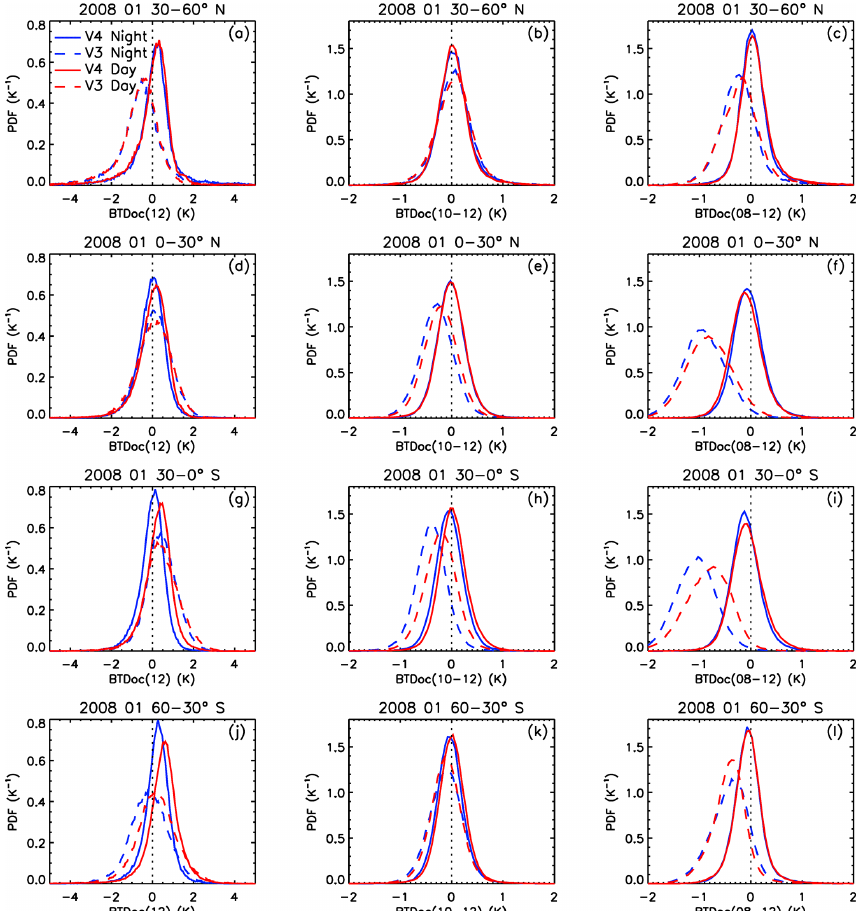
Figure 3. Probability density functions (PDFs) of the differences between observed and computed brightness temperatures (BTDoc) over oceans in January 2008 in V4 pristine (no cleared clouds) nighttime (blue) and daytime (red) clear-sky conditions in V4 (solid lines) and in V3 (dashed lines). Panels (a) , (d) , (g) , (j) : BTDoc at 12.05µm. Panels (b) , (e) , (h) , (k) : 10–12 inter-channel BTDoc difference. Panels (c) , (f) , (i) , (l) : 08–12 inter-channel BTDoc difference. The PDFs are shown at 30–60 ◦ N (a, b, c) , 0–30 ◦ N (d, e, f) , 30–0 ◦ S (g, h, i) , and 60–30 ◦ S (j, k, l)